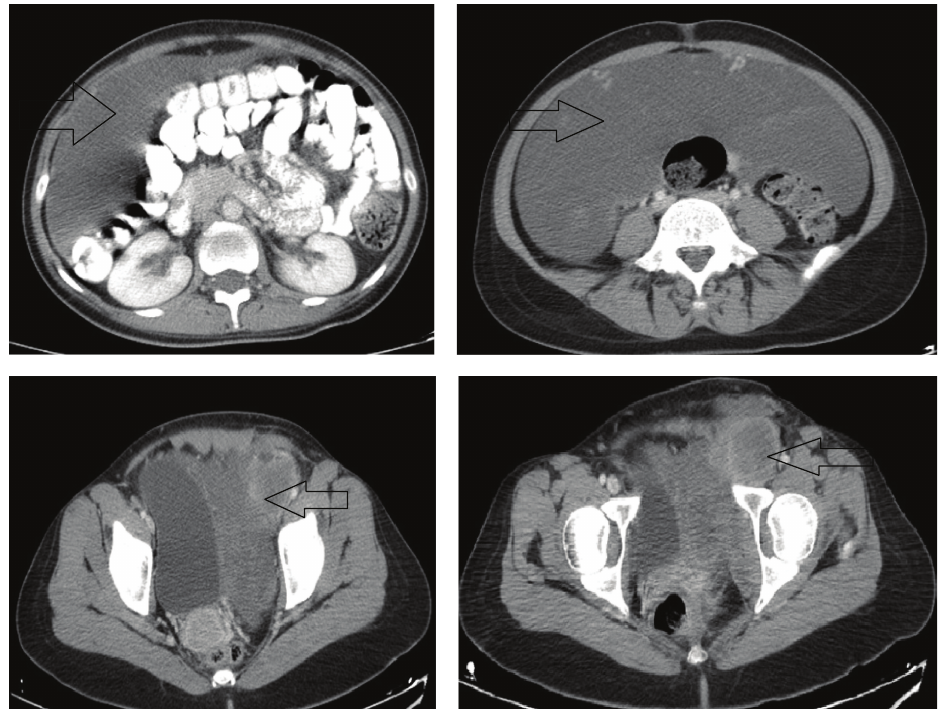
Figure 1: Computed tomography findings of the